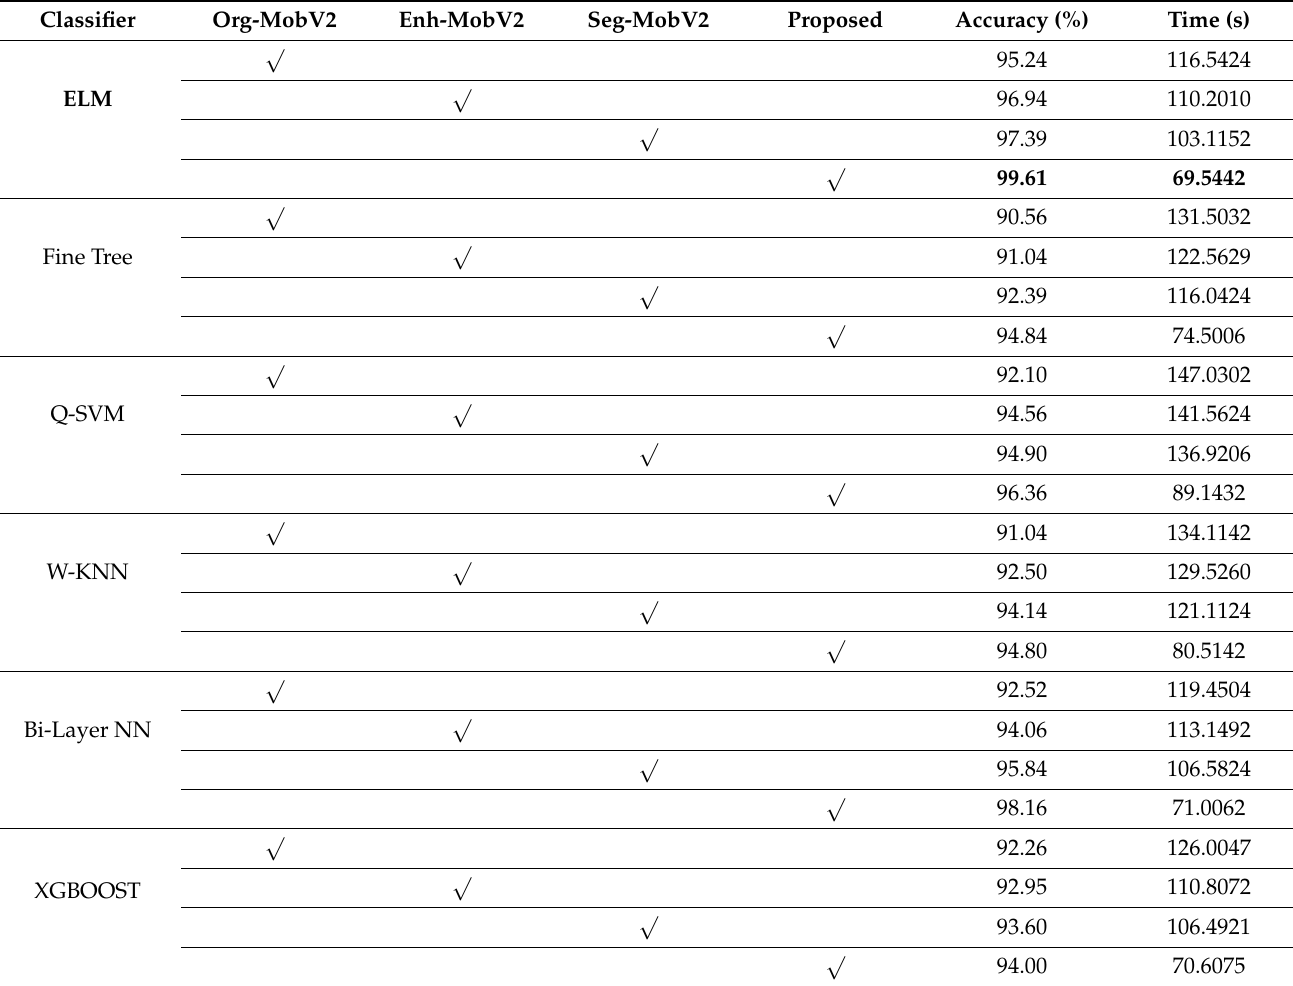
Table 1. Proposed framework classification results on CUI WCE